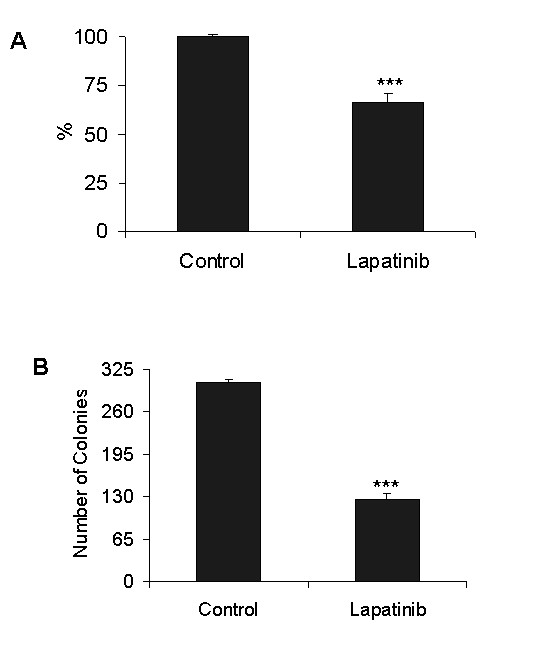
Analysis of cell survival after 2 μM lapatinib treatment. A. A549 cells exposed to 2 μM lapatinib for 24 h exhibited a reduced cell growth proliferation (P < 0.001); B. After 10 days of exposure to lapatinib, the number of colonies was dramatically abrogated (***: P < 0.0001).